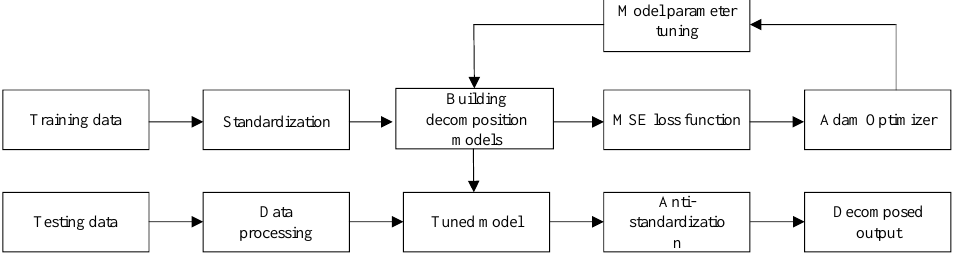
Figure 5. Algorithm flow.